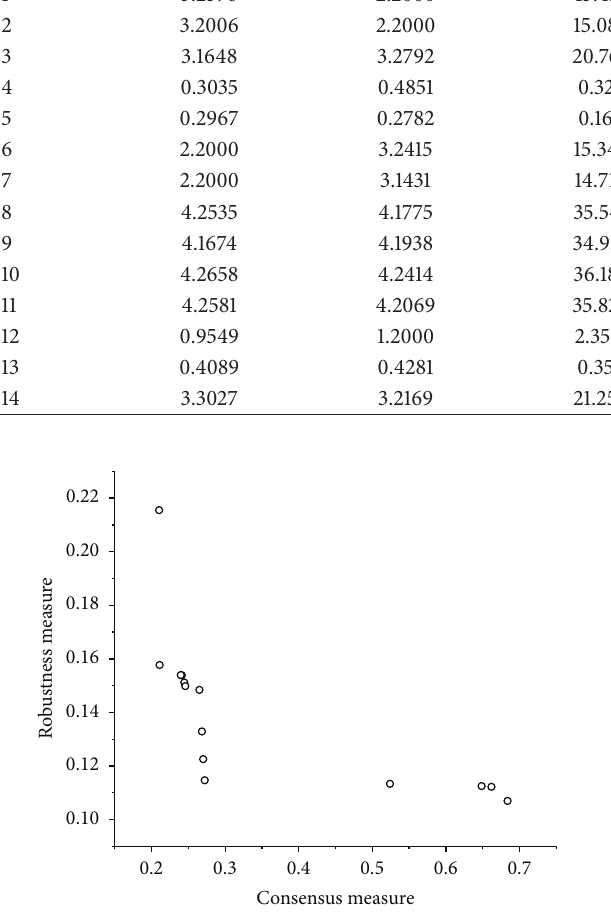
Figure 5: The consensus and robustness measures of the obtained non-dominated solutions of M-BINH problem with reference